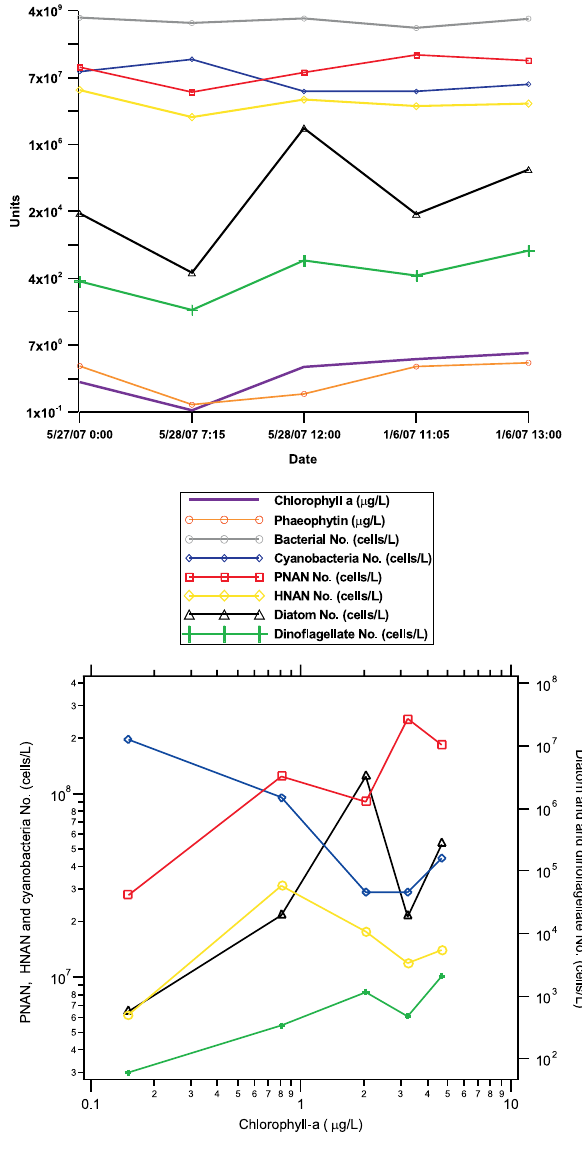
Fig. 2. Cells counts, chlorophyll- a and phaeophytin analysis of samples collected during the RHaMBLe cruise (left) and relation- ship between phytoplankton and cyanobacteria cell counts with chlorophyll- a concentration (right). The phytoplankton population was dominated by the nanoplankton group (HNAN: 10%, PNAN, 89%), followed by diatoms (0.5%) and dinoflagellates (0.0005%).